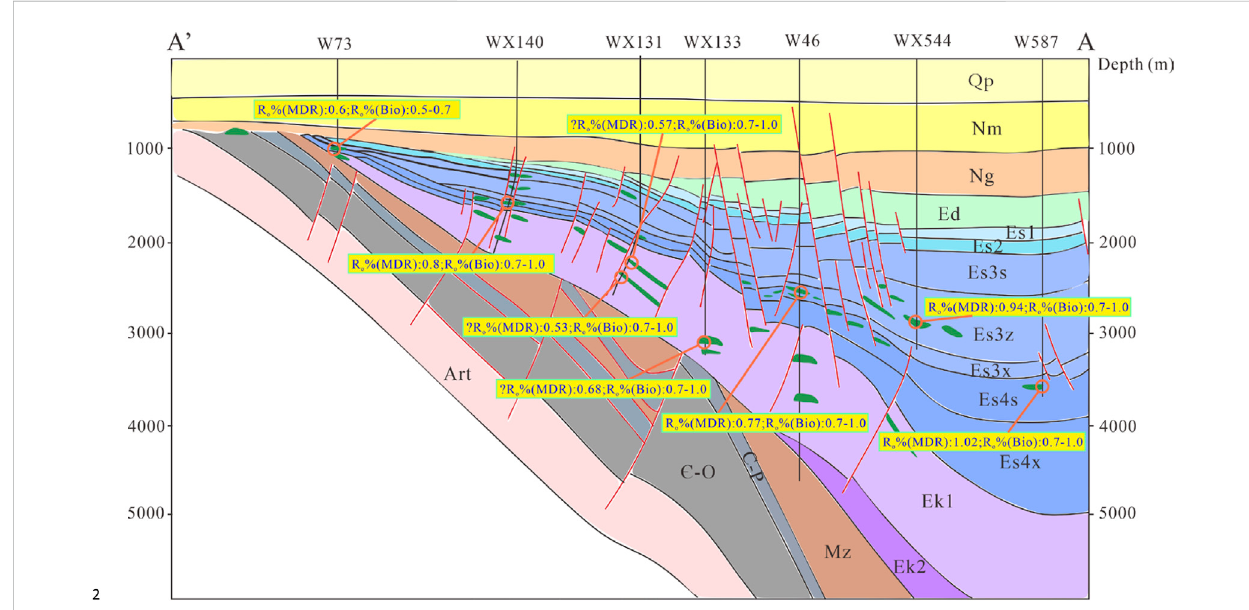
FIGURE 15 Oil charging and mixing model from sag to slope in the study area (Pro fi le location in Figure 1C). The maturity window de fi ned by R o % (Bio) values is derived from